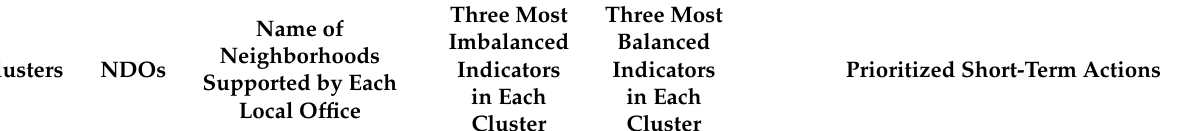
Table 2. Prioritized short-term actions for the neighborhoods of each